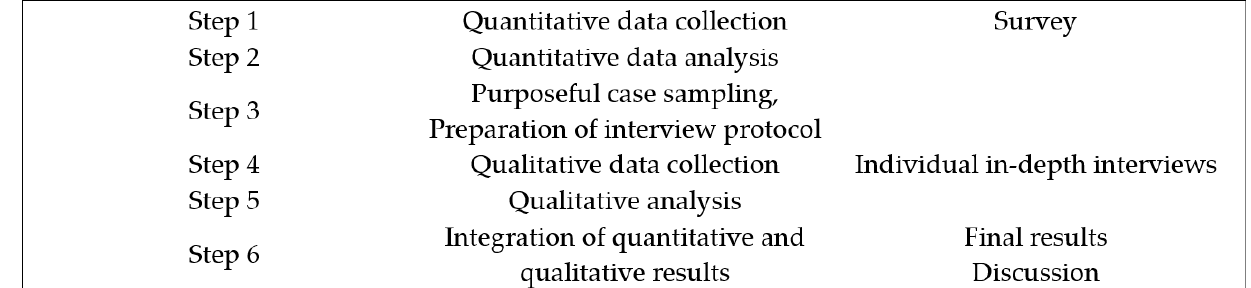
Figure 1. Explanatory sequential design by Cresswell and Plano Clark [22].